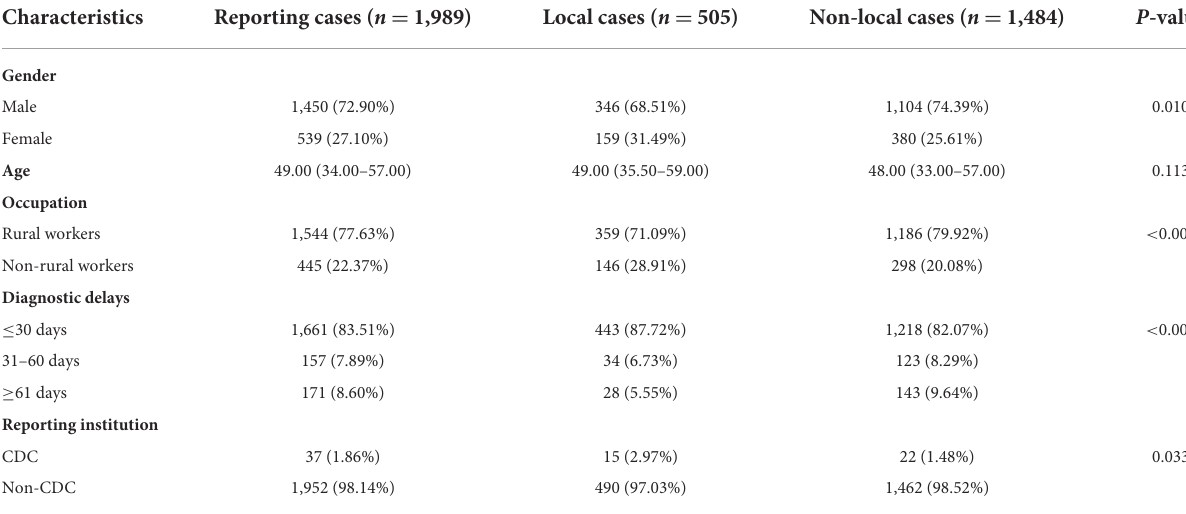
TABLE 1 Epidemiological characteristics of local and non-local cases in Xi’an from 2008 to